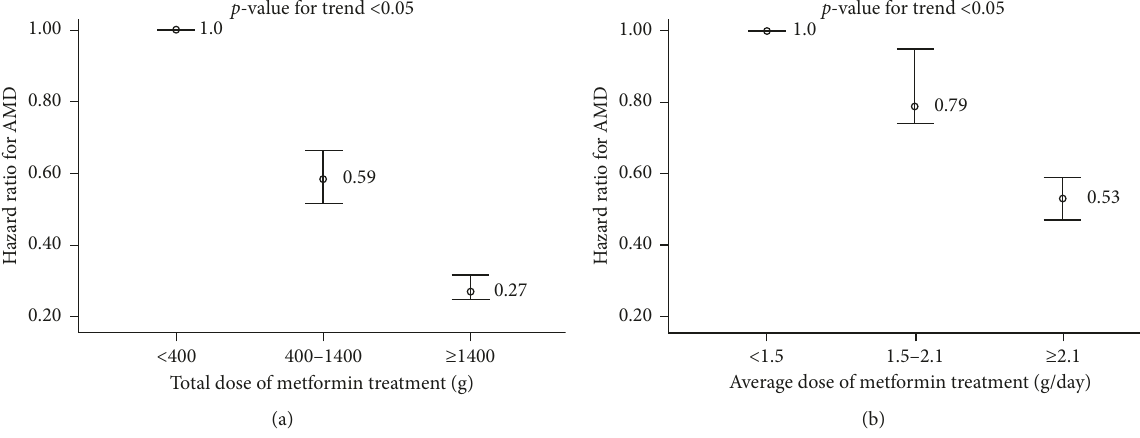
Figure 4: Risk of AMD according to (a) total dose and (b) average dose of metformin. AMD: age-related macular